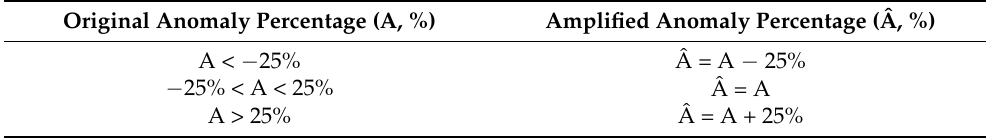
Figure 1. The rain gauge stations (red dots in the grey shaded area) are selected for calculating the precipitation over the MLYR ( upper panel ). The rectangular borderlines indicate the traditional geographical MLYR domain. The lower panel shows the composites of the prophase winter SST anomalies in high ( left column ) and low ( right column ) precipitation years for the four rain gauge stations marked in the upper panel. The station labels (i.e., A, B, C, and D) are shown at the lower left corner. Table 1. The original precipitation anomaly percentage (A, %) and corresponding amplified anomaly percentage (Â, %).